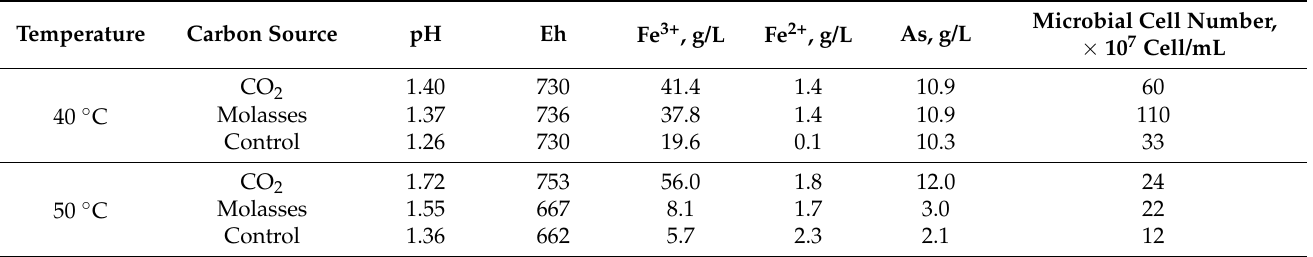
Table 2. Parameters of the liquid phase of the pulp at the end of the experiment (on the 40th day). Temperature Carbon